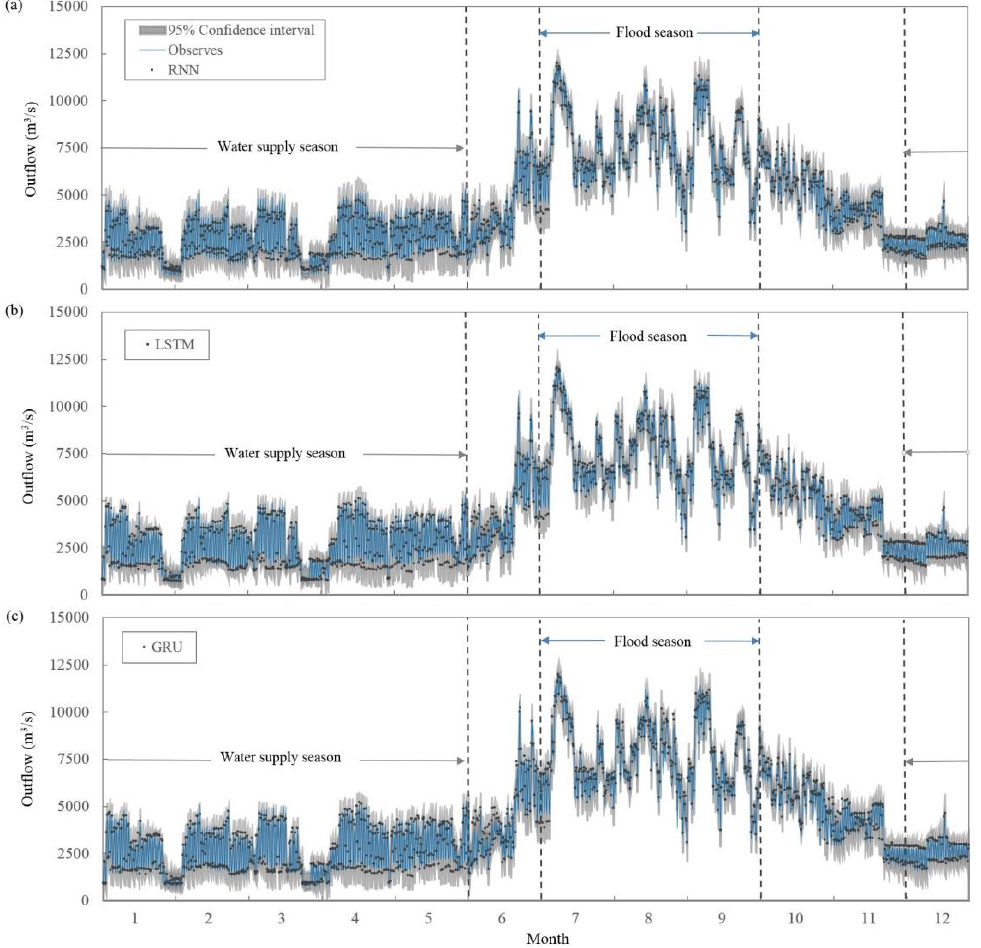
Figure 9. Comparison of predicted and observed outflow using RNN ( a ), LSTM ( b ) and GRU ( c ) algorithm.